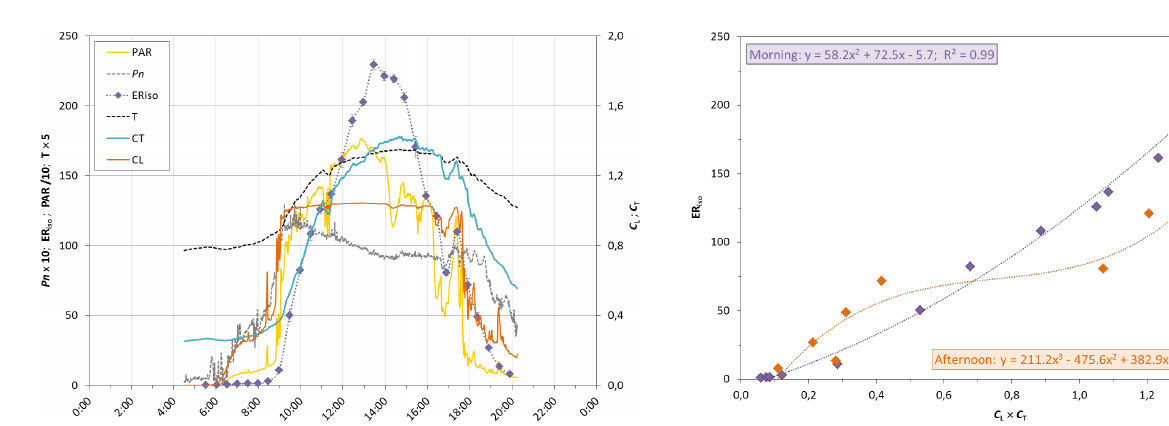
Figure 4. (a) Diurnal variations of isoprene emission rate ER iso (µgCg − 1 footbridge with (b) corresponding PAR (µmolm − 2 s − 1 ) and temperature T ( ◦ C) conditions.